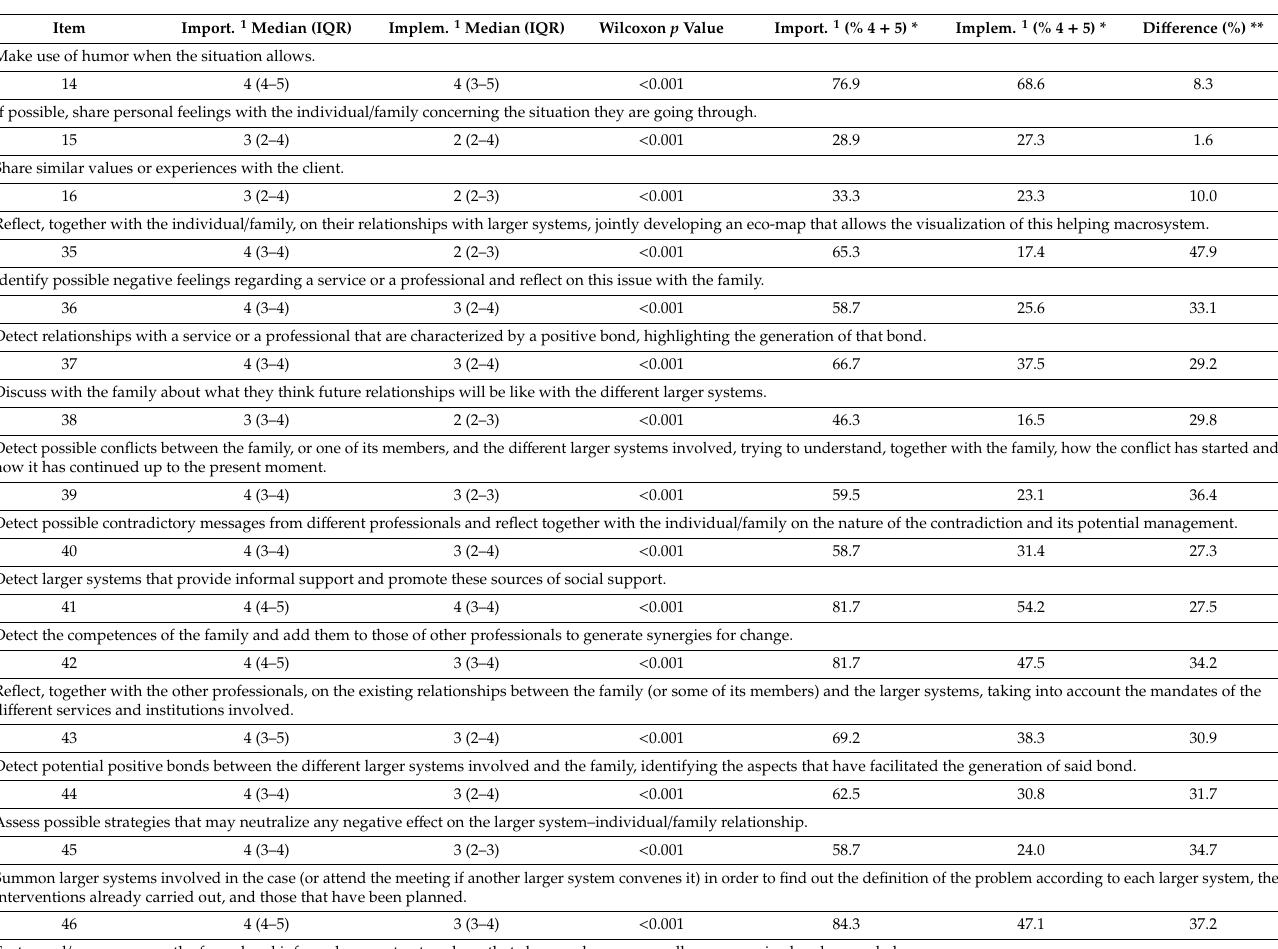
Table 2. Factor I: assessment of relationships between family and larger